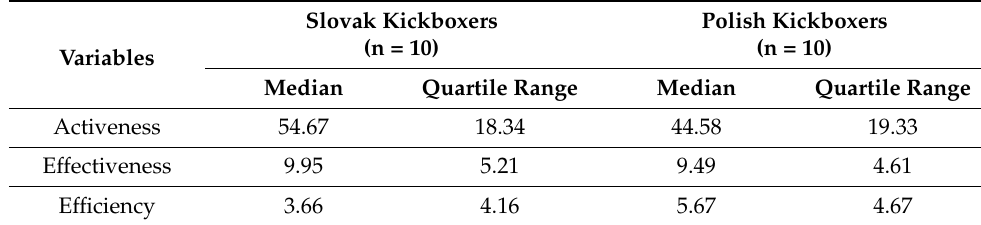
Table 3. Activeness, effectiveness and efficiency of the attacks.